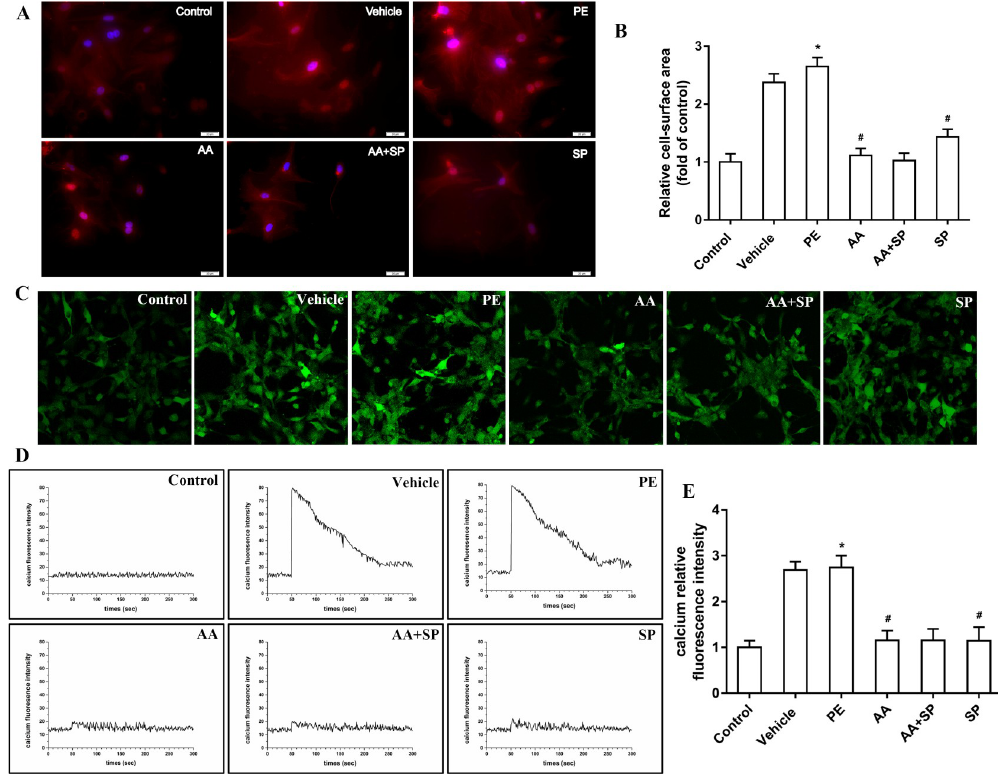
Fig 6. The HATs inhibitor anacardic acid (AA) and the JNK inhibitor SP600125 attenuates cardiomyocyte hypertrophy induced by phenylephrine (PE). (A) The cell surface area was measured by immunofluorescence staining to demonstrate hypertrophic responses in cardiomyocytes. Myocardial cell were stained using α -actin (red fluorescence) combined with DAPI (blue fluorescence). (B) Measurement of the cell surface area of myocardial cells for the quantification of cell size. (C) Determination of intracellular Ca 2+ concentrations using the calcium fluorescent probe Flou-3/AM and laser scanning confocal microscopy. (D) Dynamic fluorescence curve of intracellular Ca 2+ in myocardial cells. (E) Comparison of intracellular Ca 2+ fluorescence intensity in myocardial cells among the six groups of PE-induced hypertrophic cardiomyocytes. � P < 0.05 vs . the control group, # P < 0.05 vs . the PE group (n = 6). Scale bars, 20 μ m. PE: phenylephrine; DMSO: dimethylsulfoxide; AA: anacardic acid; SP: SP600125 (JNK inhibitor). Fluorescence quantification was done using ImageJ 1.8.0_112 software (https://imagej.nih.gov/ij/, 1997–2018). Figure created in IBM SPSS version 25